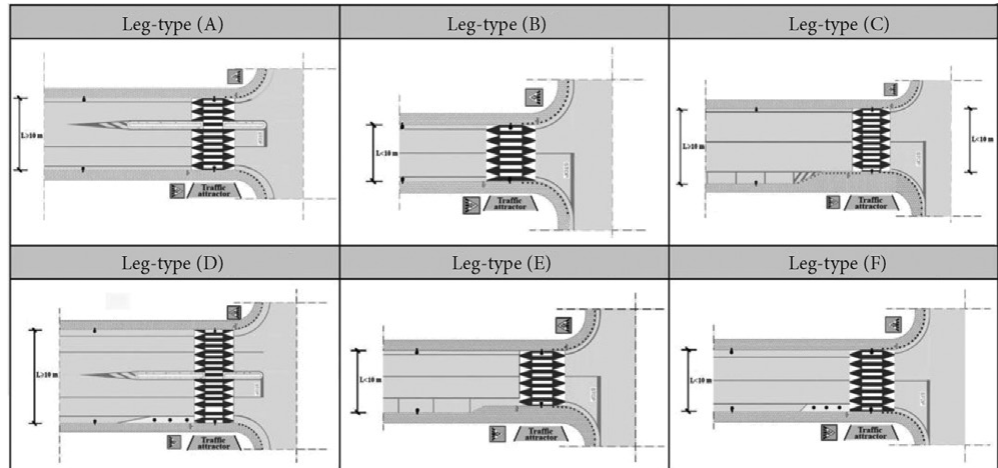
Fig. 1. Legs-type for the composition of the virtual